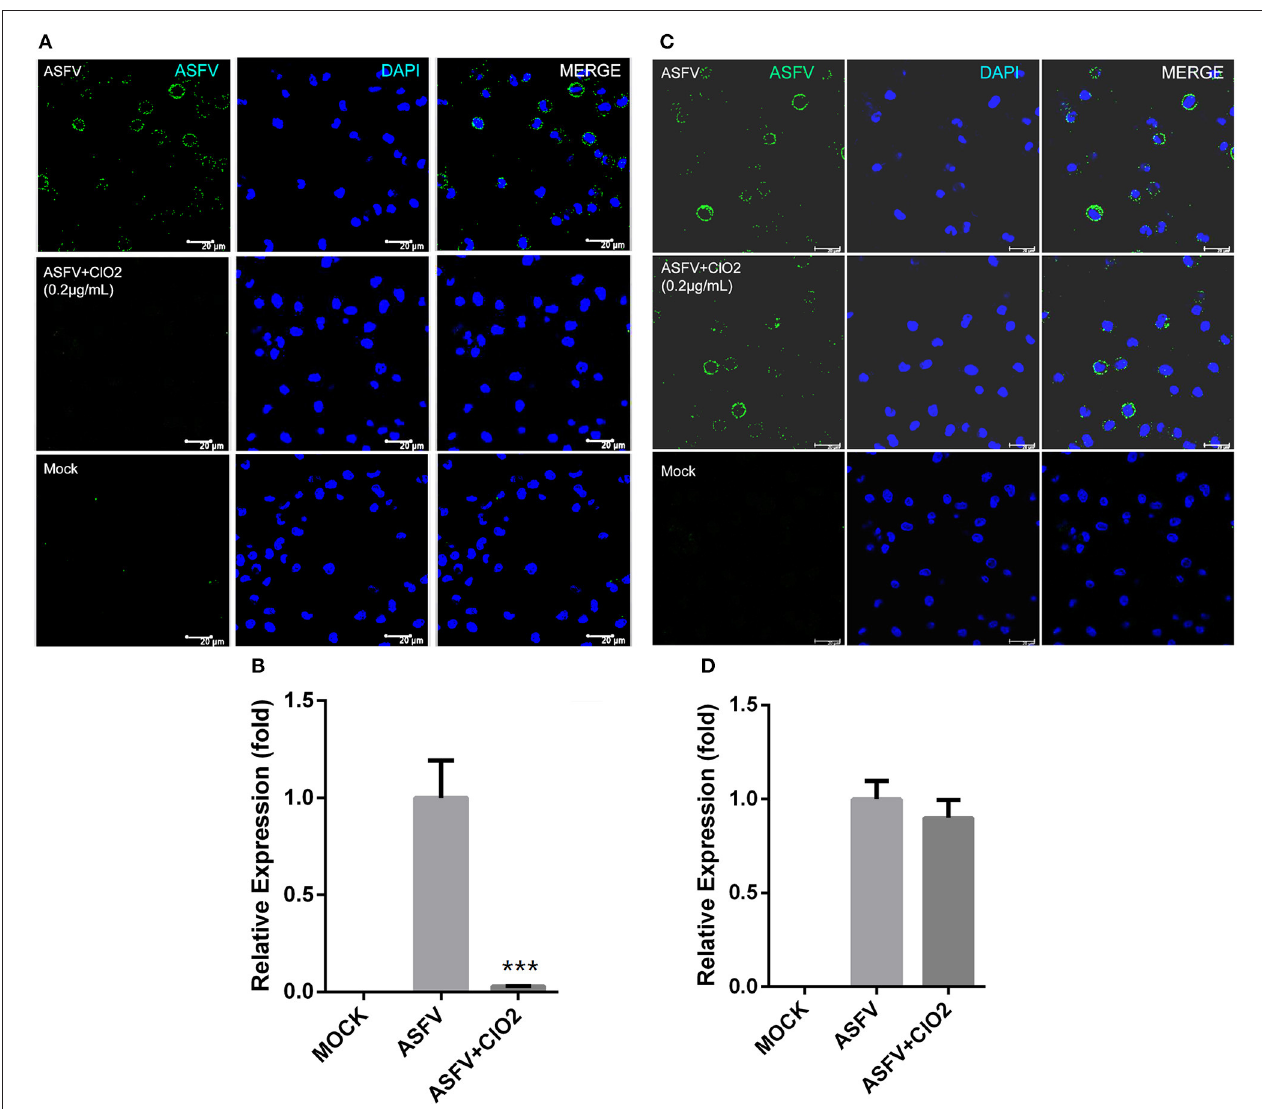
FIGURE 6 | ClO 2 inhibits virus adsorption rather than entry during ASFV life cycle. (A,B) Cells were pre-chilled for 30min at 4 ◦ C and mock-infected or infected with ASFV (MOI = 1) in the presence or absence of ClO 2 . After cultured for 3h at 4 ◦ C, cells were then washed and switched to 37 ◦ C for additional 4h. The inhibitory effect was determined by IFA (A) and qRT-PCR (B) assays. Bar, 20 µ m. (C,D) For the viral entry assay, cells were cooled for 30min at 4 ◦ C and mock-infected or infected with ASFV at an MOI of 1 for 3h at 4 ◦ C. Cells were then washed three times to remove unbound virions and incubated at 37 ◦ C in the presence or absence of ClO 2 for 4h. Cells were fixed and stained for ASFV p30 protein using fluorescence microscope (C) or collected to determine the mRNA level of viral p72 protein (D) . Bar, 20 µ m. Data are representative of the results of three independent experiments (means ± SE). Significant differences compared with control group are denoted by *** P <